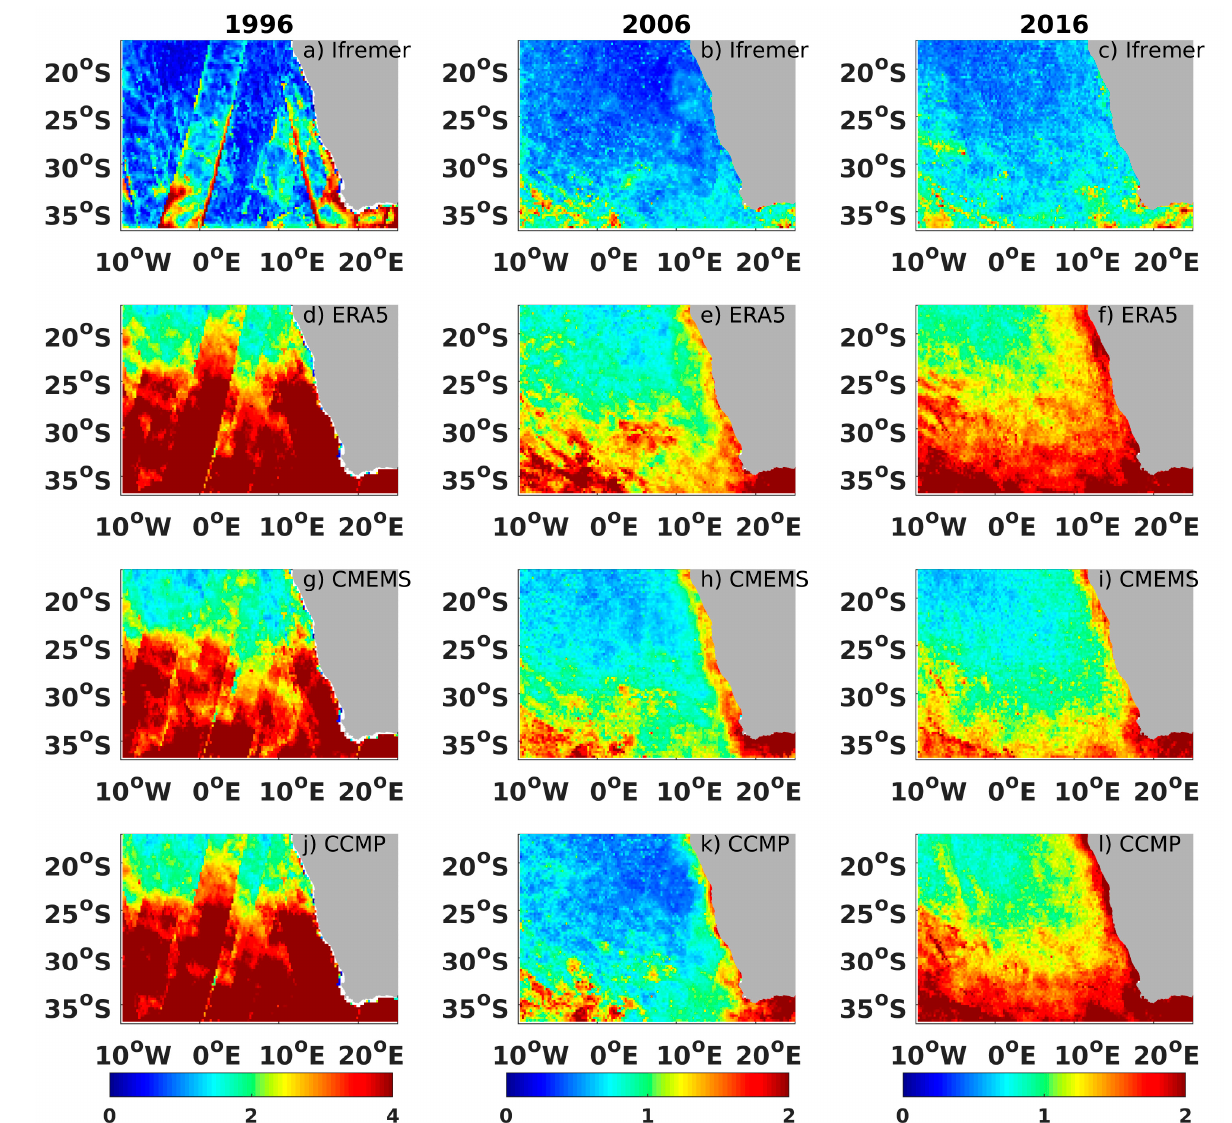
Figure A6. Spatial distributions of root mean square of zonal wind component differences between collocated scatterometer retrievals and satellite wind analyses, referenced as Ifremer, ( a – c ), ERA5 wind estimates ( d – f ), CMEMS winds ( g – i ), and CCMP winds ( j – l ). The results are drawn from data occurring, over Benguela zone, in 1996 (panels in left column), 2006 (middle column), and 2016 (right column). Color indicates RMSD values in m/s. One should notice that the color bar associated with 1996 is different from the 2006 and 2016 ones.